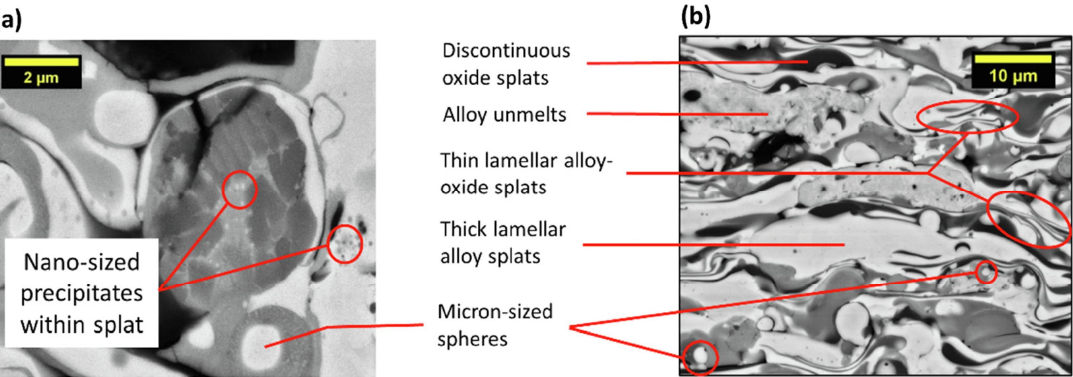
Figure 6. Backscattered scanning electron micrographs of atmospheric plasma spraying (APS) of AlCoCrFeNi HEA coatings. ( a ) shows a high-magnified image highlighting the nanoscale precipitates within the splats. ( b ) represents SEM images with different distinct regions (black, white, and gray phases) along with different splats (oxides, thick splats, thin splats, and partial and unmelted particles) [34].